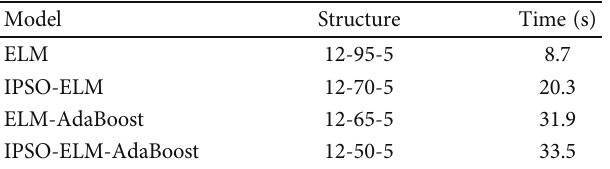
Table 4: Results of four algorithms.